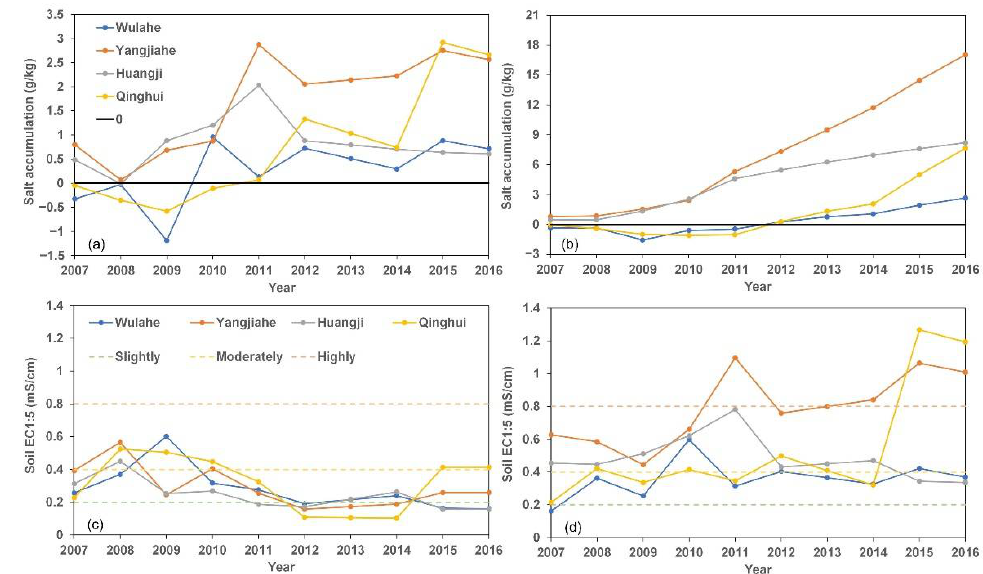
Figure 7. The salt accumulated in the 0–40 cm soil layer during each cropping season ( a ) and its cumulative amount ( b ), and the soil EC1:5 (mS/cm) at the beginning ( c ) and at the end ( d ) of each cropping season of Wulahe, Yangjiahe, Huangji and Qinghui sections in the Jiefangzha Subdistrict (JFZSD) from 2007 to 2016. The dashed lines indicate the classification of the saline soils.